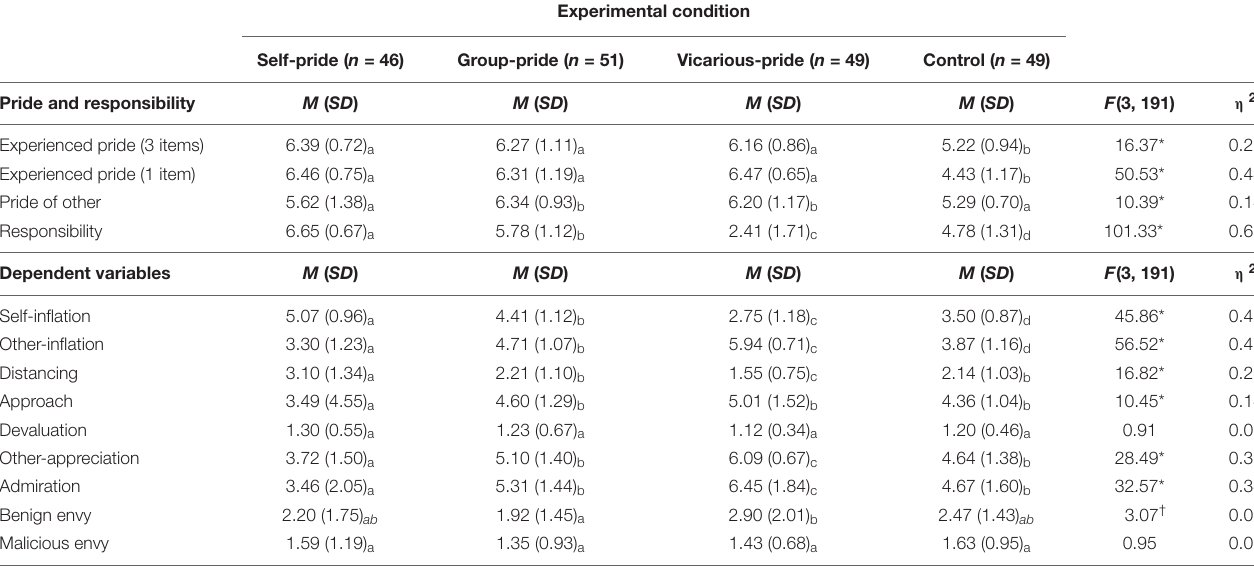
TABLE 2 | Means, standard deviations, and statistics of all dependent variables in Experiment